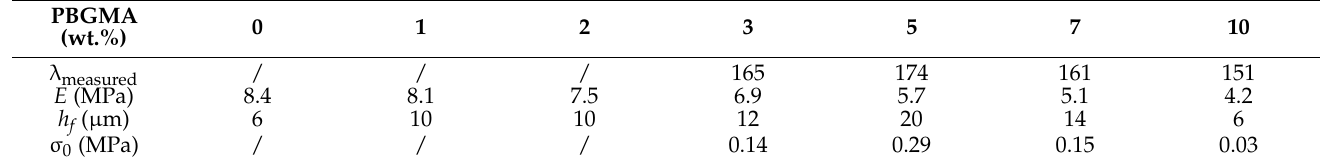
Figure 10. CRM analysis of epoxy conversion as a function depth for the 5 wt.% PBGMA system. Table 5. Measured wrinkle wavelength, estimated Young’s modulus, skin thickness, and compressive stress of the systems with various PBGMA